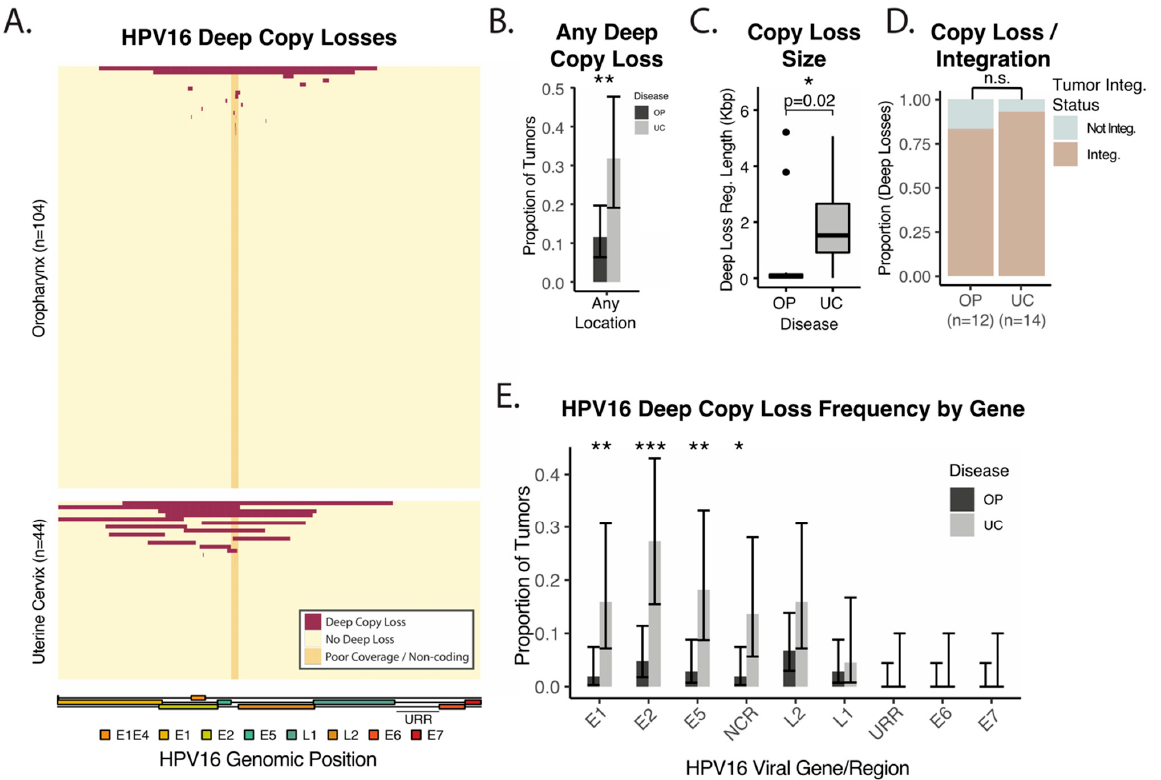
Figure 3. Deep losses of HPV16 genomic material in OPSCC and UCSCC. ( A ) Heatmap—regions of deep loss in the HPV16 genome by tumor. Columns—HPV16 genomic position. Rows—tumors. Dark Red—deep loss. Yellow—no deep loss. Orange—hypervariable non-coding region with poor coverage, excluded from deep loss analysis unless otherwise indicated. ( B ) Bar plot—proportion of tumors with any deep genomic loss in the HPV16 genome. Error bars represent 95% CI. ( C ) Boxplot—size distribution of regions of deep copy loss. p -value represents Wilcoxon rank-sum test. ( D ) Stacked bar plot—proportion of tumors with deep loss and viral integration. ( E ) Bar plot—proportion of tumors with deep genomic loss affecting the indicated regions of the HPV16 genome. Error bars represent 95% CI. NCR—hypervariable non-coding region with poor coverage (also orange in Panel A ). URR—upstream regulatory region. * p -value < 0.05. ** p -value < 0.005. *** p -value < 0.0005.